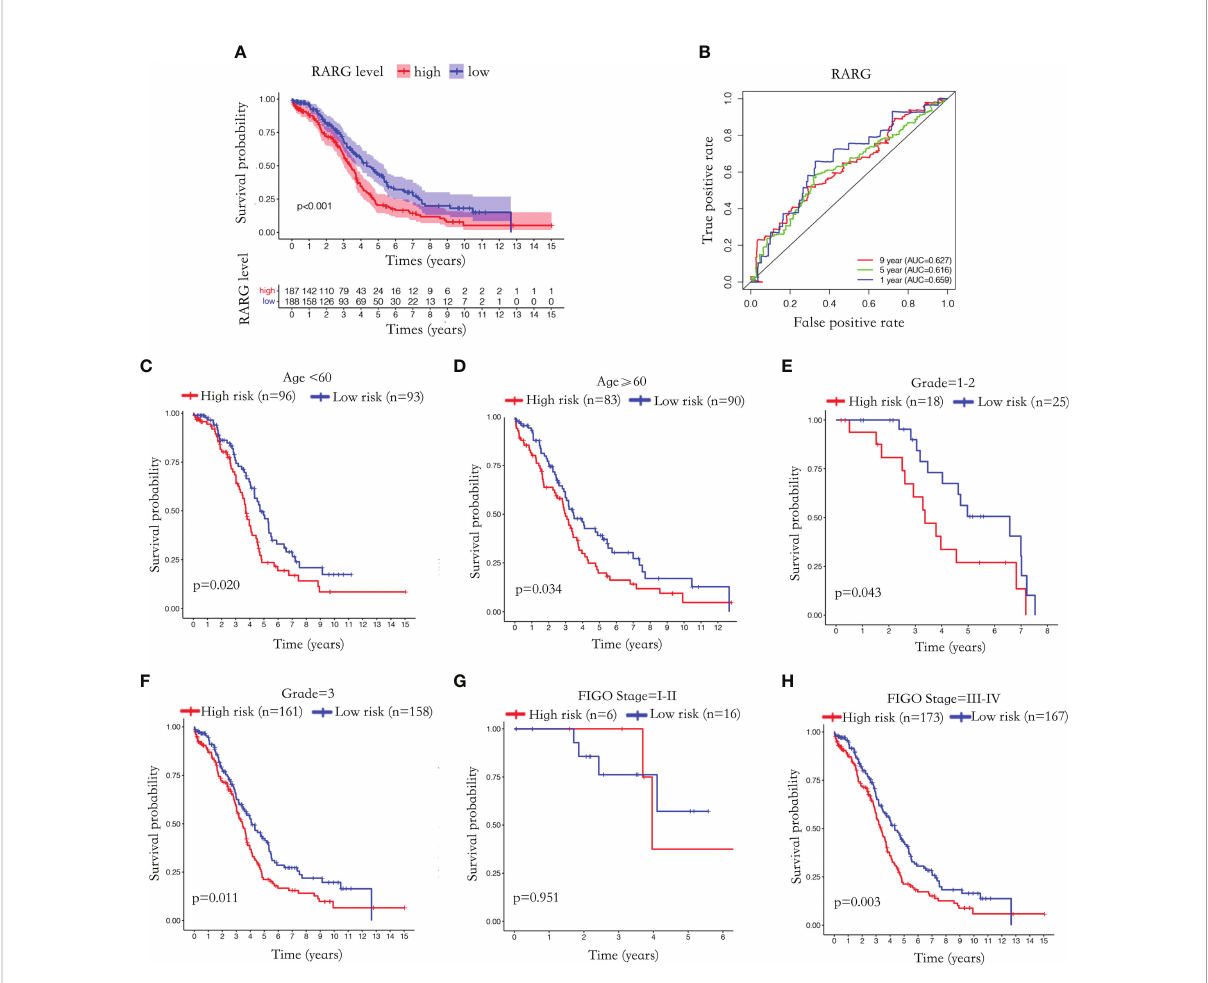
FIGURE 2 Abnormal elevation of RARG mRNA level was positively correlated with poor prognosis. (A) The Kaplan-Meier survival curves of the RARG high expression group and the low expression group. (B) ROC curves were used to assess the ef fi ciency of RARG for predicting 1, 5 and 9 year survival. (C – H) The Kaplan-Meier survival curves of RARG high expression group and low expression group in the age<60 subgroup (C) , age ≥ 60 subgroup (D) , grade 1-2 subgroup (G) , grade 3 subgroups (H) , stage I-II subgroup (E) , stage III-IV subgroup (F)